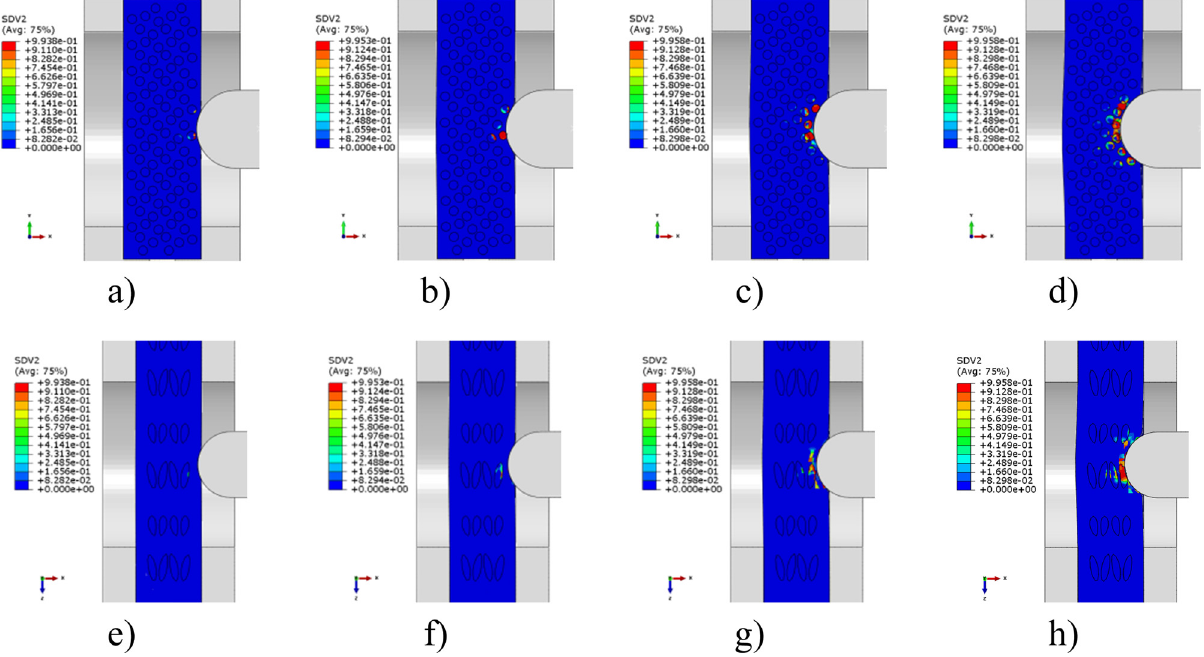
Figure 16: Longitudinal compression damage of fi ber bundles and matrix: ( a and b ) damage expansion process at beginning, middle late, and end of fi ber bundles; ( e – h ) damage expansion process at beginning, middle, late, and end of